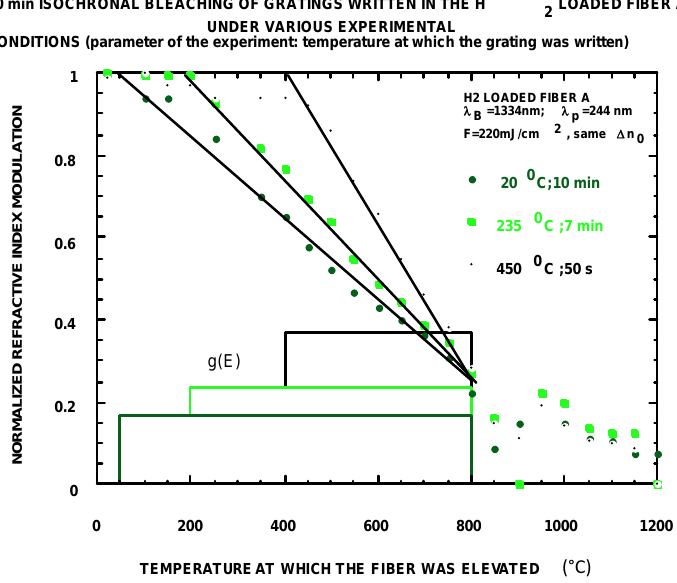
Figure 38. Stability of gratings written with the same Δ n 0 but at a different